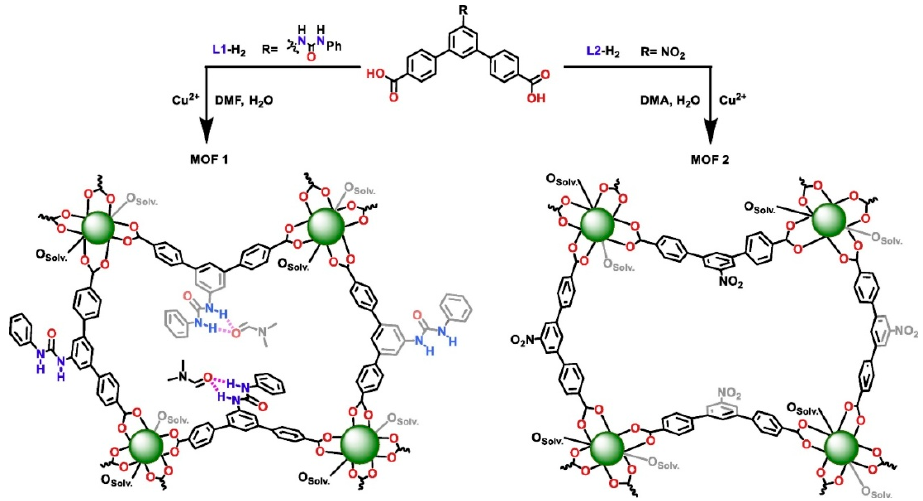
Figure 5. Synthesis of urea containing MOFs from V-shaped dicarboxylate linkers. Reprinted with permission from [57]. Copyright (2020) Elsevier.